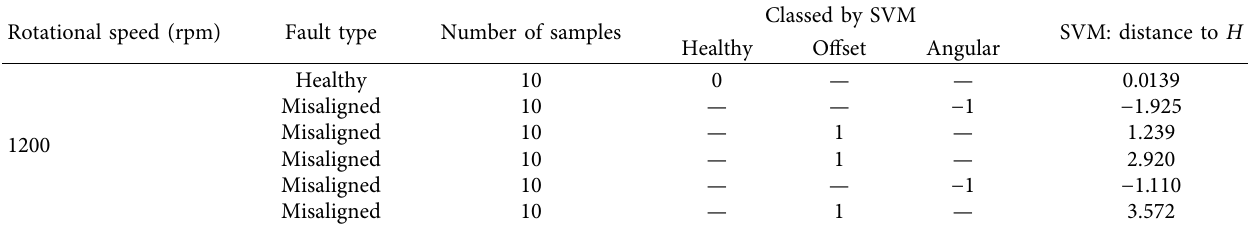
Table 5: SVM multifault classifier output for selected samples at